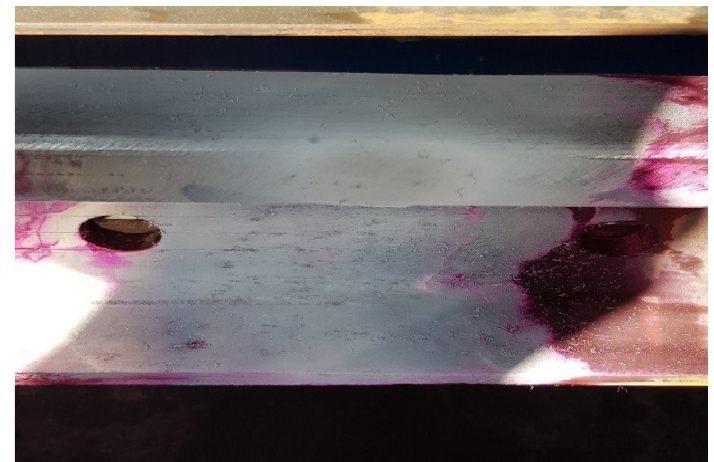
Figure 10. Developer application process. Source: own.